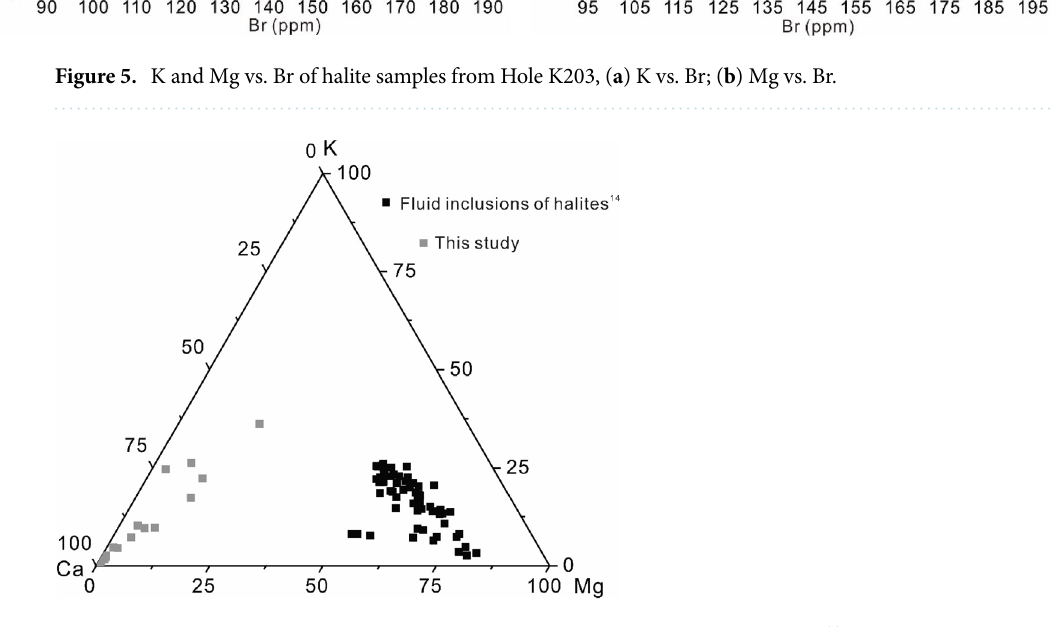
Figure 6. Compositions of halite fluid inclusions from the Maha Sarakham Formation 14 and halite